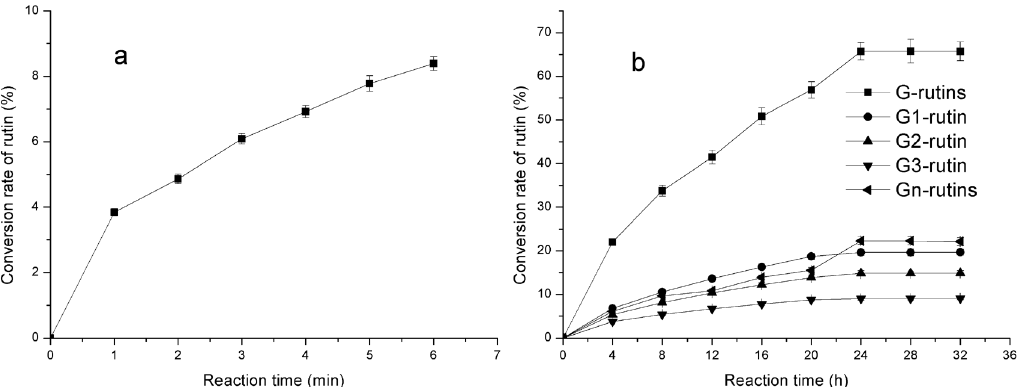
Figure 6. Time-courses of the conventional method for rutin transglycosylation in 0-6 min ( a ) and 0–32 h ( b